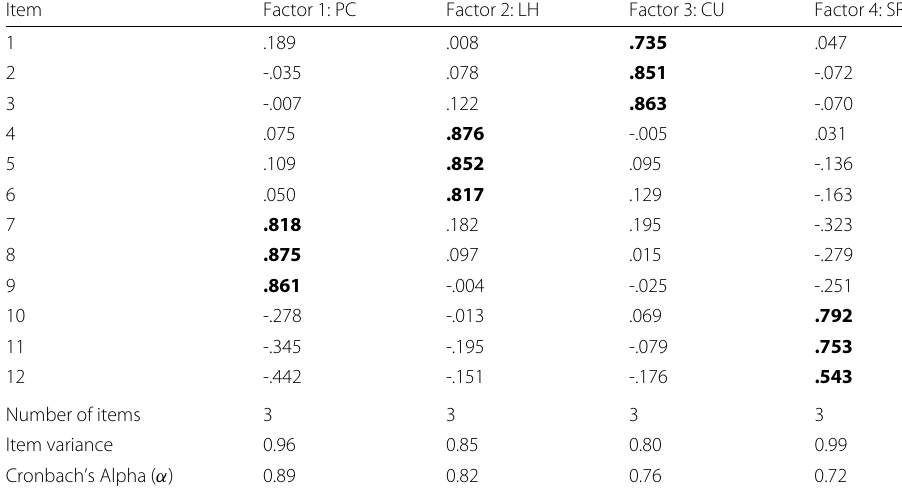
Table 3 Classification of questions based on factor analysis and reliability coefficients of the factors CU, LH, PC and SR in the